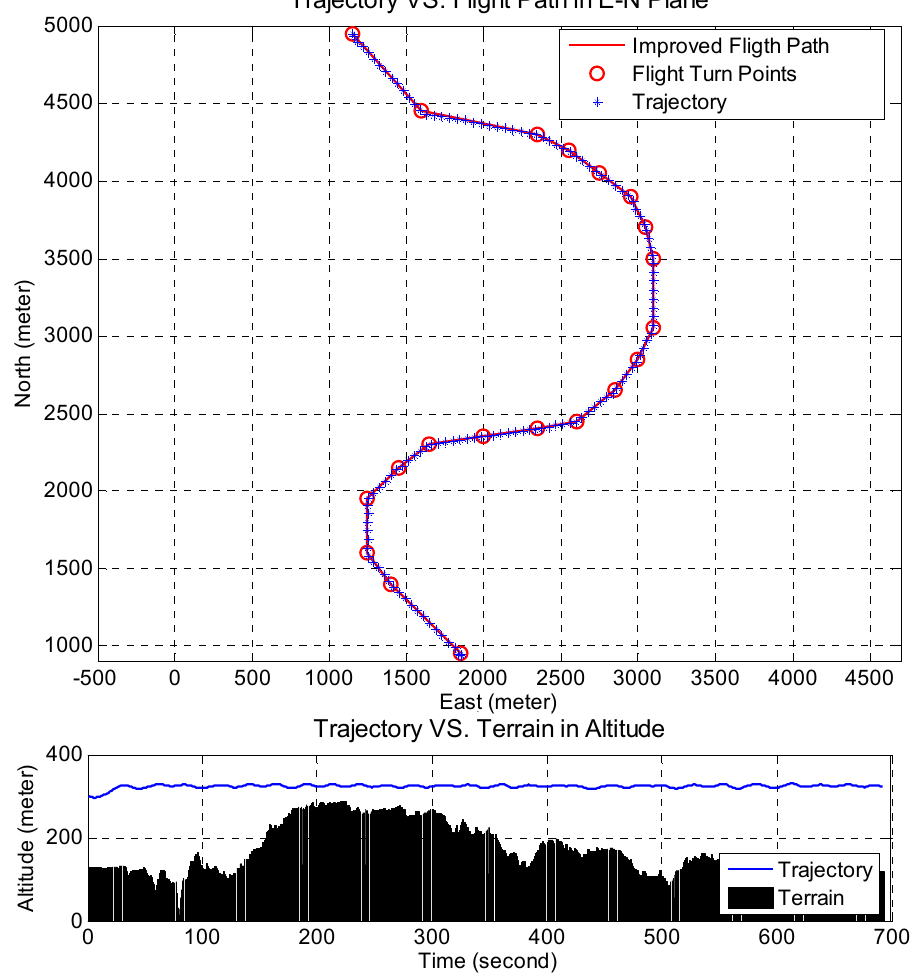
Figure 24. The resulting trajectory in the horizontal plane and the corresponding altitude